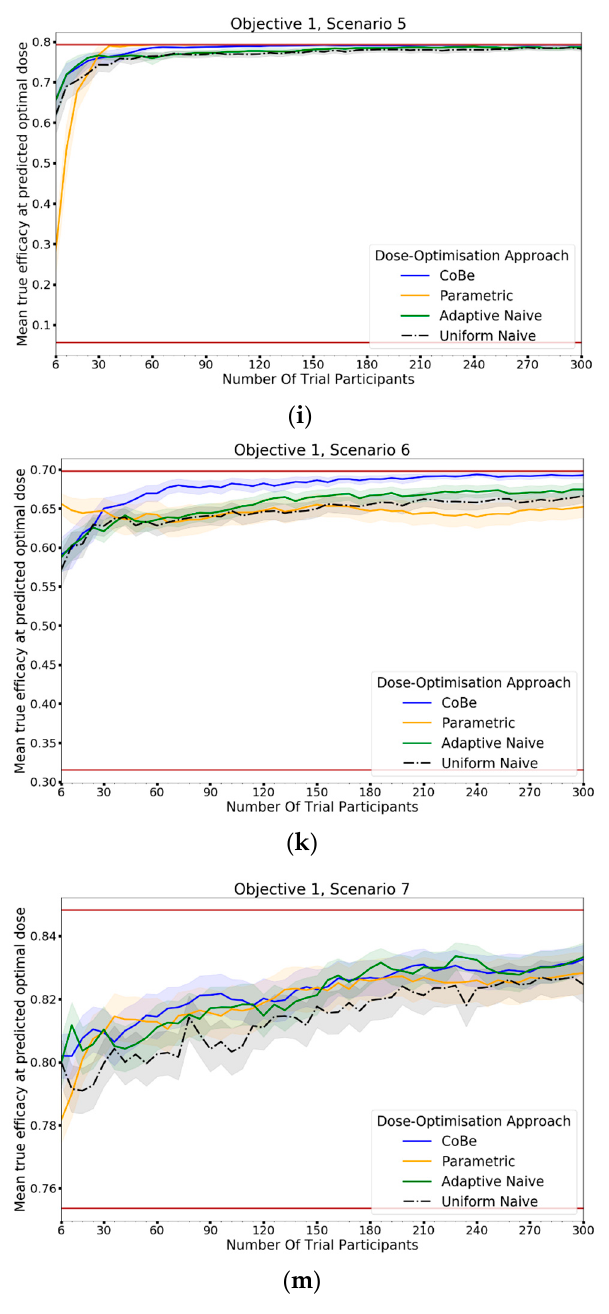
Figure 10. Mean true efficacy at the predicted optimal dose (left) and mean cumulative sum of efficacy (right) against trial size for all seven objective 1 scenarios (Scenario 1 ( a , b ), Scenario 2 ( c , d ), Scenario 3 ( e , f ), Scenario 4 ( g , h ), Scenario 5 ( i , j ), Scenario 6 ( k , l ), Scenario 7 ( m , n )). These are the mean values and 95%CI values across 100 simulations. For the true efficacy plots (left), the brown lines show the minimum and maximum possible efficacy that could be achieved in that scenario. For the cumulative efficacy plots (right) the brown lines represent the maximum and minimum cumulative efficacy sum that could be expected for that scenario. For example, if the true maximum efficacy for a scenario was 90%, no DOA could locate a dose with a true efficacy >90%, and no DOA could achieve a mean cumulative efficacy > 270 (=90% × 300) after testing 300 trial participants. A mean true efficacy/mean cumulative sum of efficacy curve being closer to the upper brown line reflects that DOA being the more effective for locating a maximally efficacious dose/maximising benefit to trial participants.